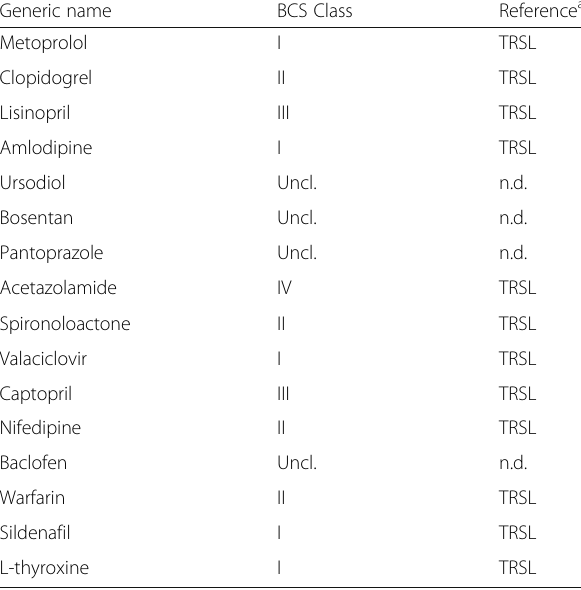
Table 2 BCS class and potential candidate molecules for pediatric drug